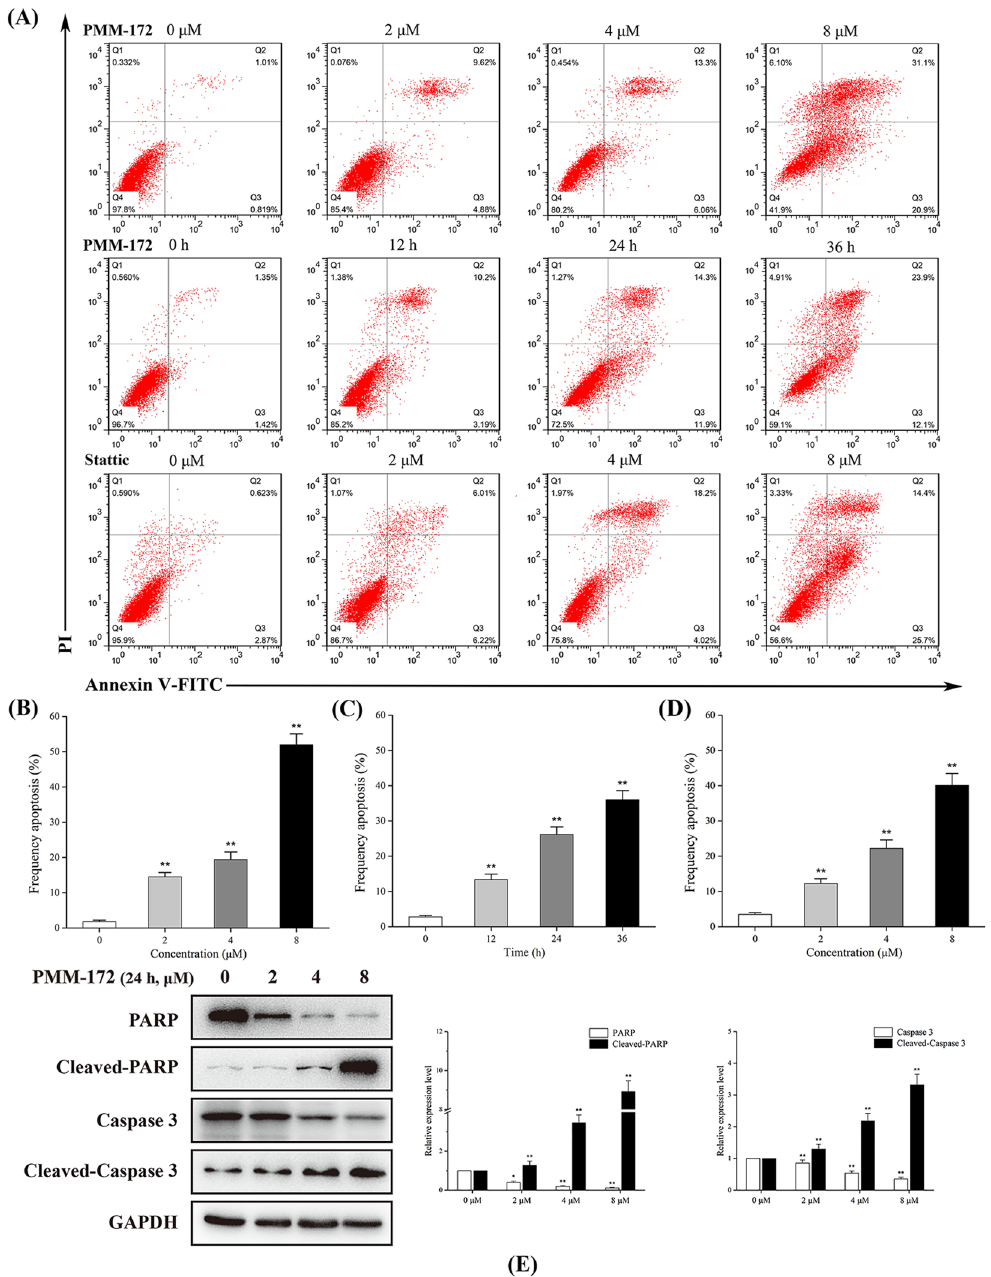
Figure 4. The effect of PMM-172 on the cell apoptosis of MDA-MB-231 cells. ( A ) MDA-MB-231 cells were treated with various concentrations of PMM-172 or Stattic for 24 h, or treated with 4 μ M PMM-172 for different time. Apoptosis was analyzed by flow cytometry by using Annexin V/PI double staining. ( B ) The percentage of apoptotic cells in MDA-MB-231 cells treated with various concentrations of PMM-172 for 24 h. ( C ) The percentage of apoptotic cells in MDA-MB-231 cells treated with 4 μ M PMM-172 for different time. ( D ) The percentage of apoptotic cells in MDA-MB-231 cells treated with various concentrations of Stattic for 24 h. ( E ) PARP and caspase 3 cleavage in MDA-MB-231 cells after treated with various concentrations of PMM-172 for 24 h were detected by using Western blot analysis. The relative expression level was analyzed by Image J software. Data were shown as mean ± SD of three independent experiments. * P < 0.05, ** P < 0.01. Cropped blots/gels were used in the figure and the gels had been run under the same experimental conditions; the full- length blots/gels are presented in Supplementary Figure